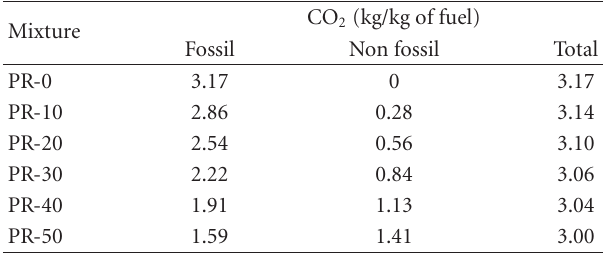
Table 10: CO 2 emissions linked to combustion of the various mix- tures of lard and diesel.